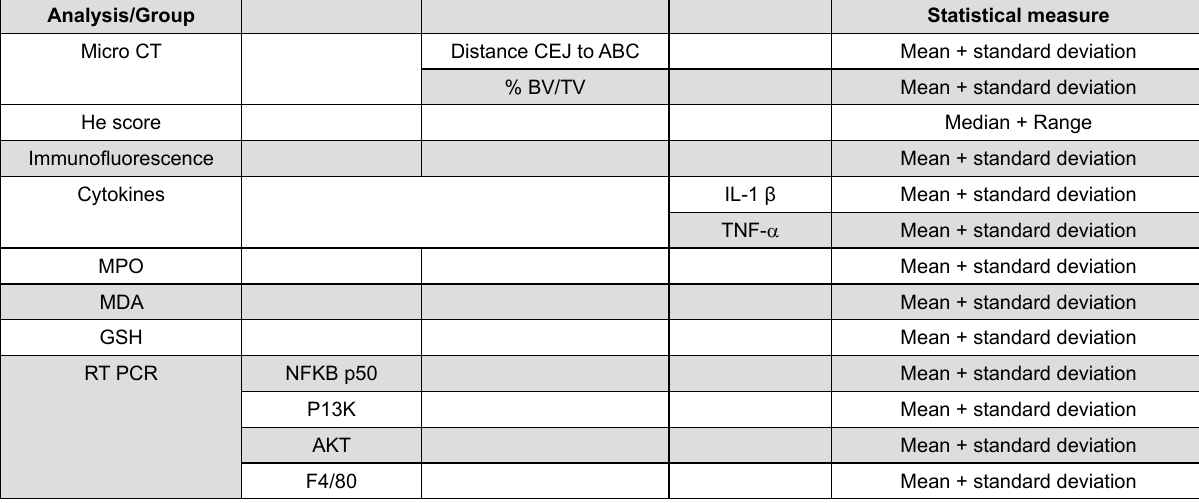
Figure 1- Analysis/group and statistical measure (central tendency and